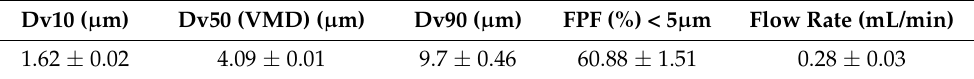
Table 2. Aerodynamic properties of the aerosolized ATRA-PLGA NPs aerosolized using Aerogen Solo VMN as measured by laser diffraction via Malvern Spraytec. Results are representative of three independent nebulization runs (n = 3), mean ± SD. VMD = volumetric median diameter, FPF = fine particle fraction.